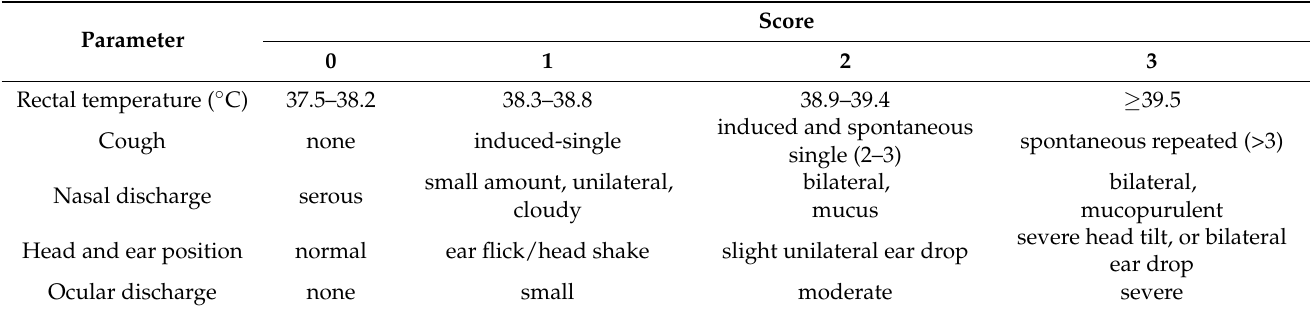
Table 1. Scoring system and definitions for daily observations in group housed calves adapted * from McGuirk and Peek